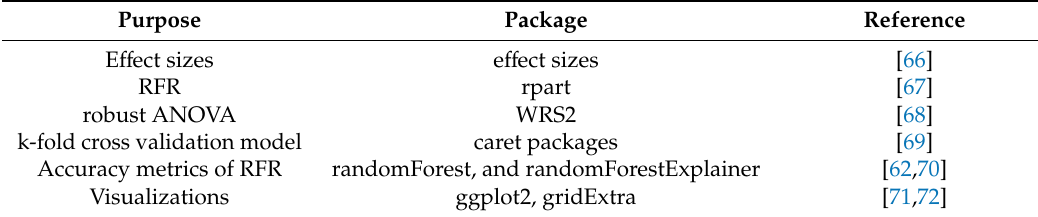
Table 1. Statistical packages used for R (V. 3.6.2) analyses.